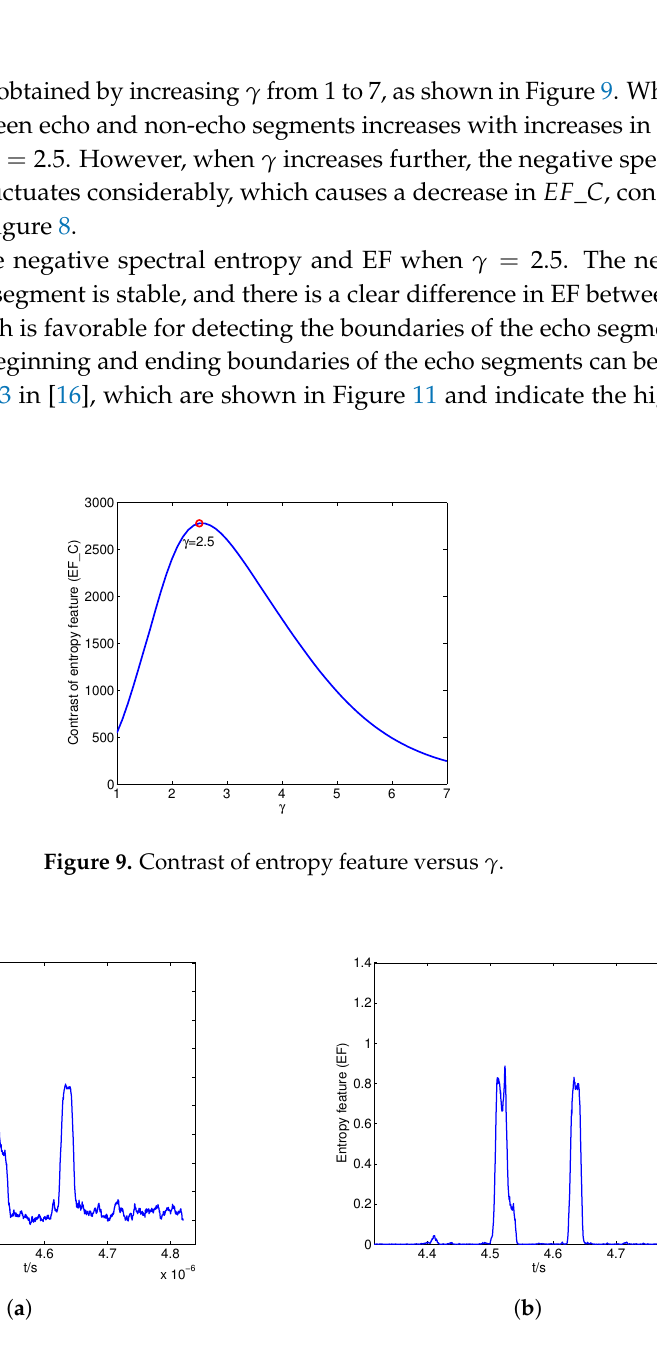
Figure 10. Negative spectral entropy ( a ) and entropy feature ( b ) for γ =